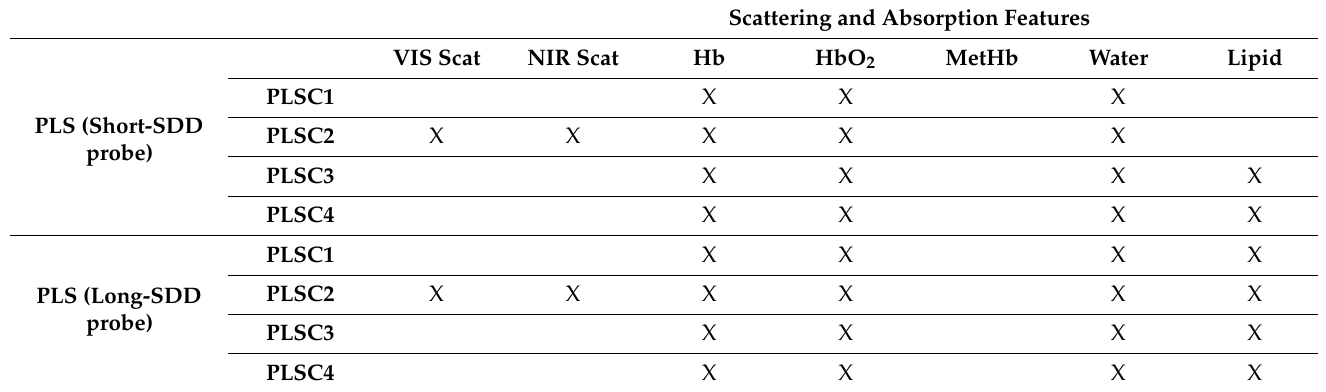
Table 4. Scattering and absorption features of the superficial tissue PLSCs. Scattering and Absorption